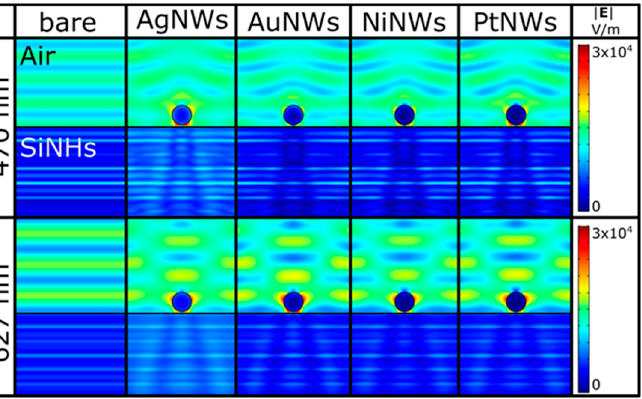
Figure 9. Electric field distributions around metallic nanowires on the SiNHs surface owing to the localized surface plasmon resonance (LSPR) response obtained at 470 nm and 627 nm illumination. For comparison, the bare SiNHs surface is also displayed in the first column.